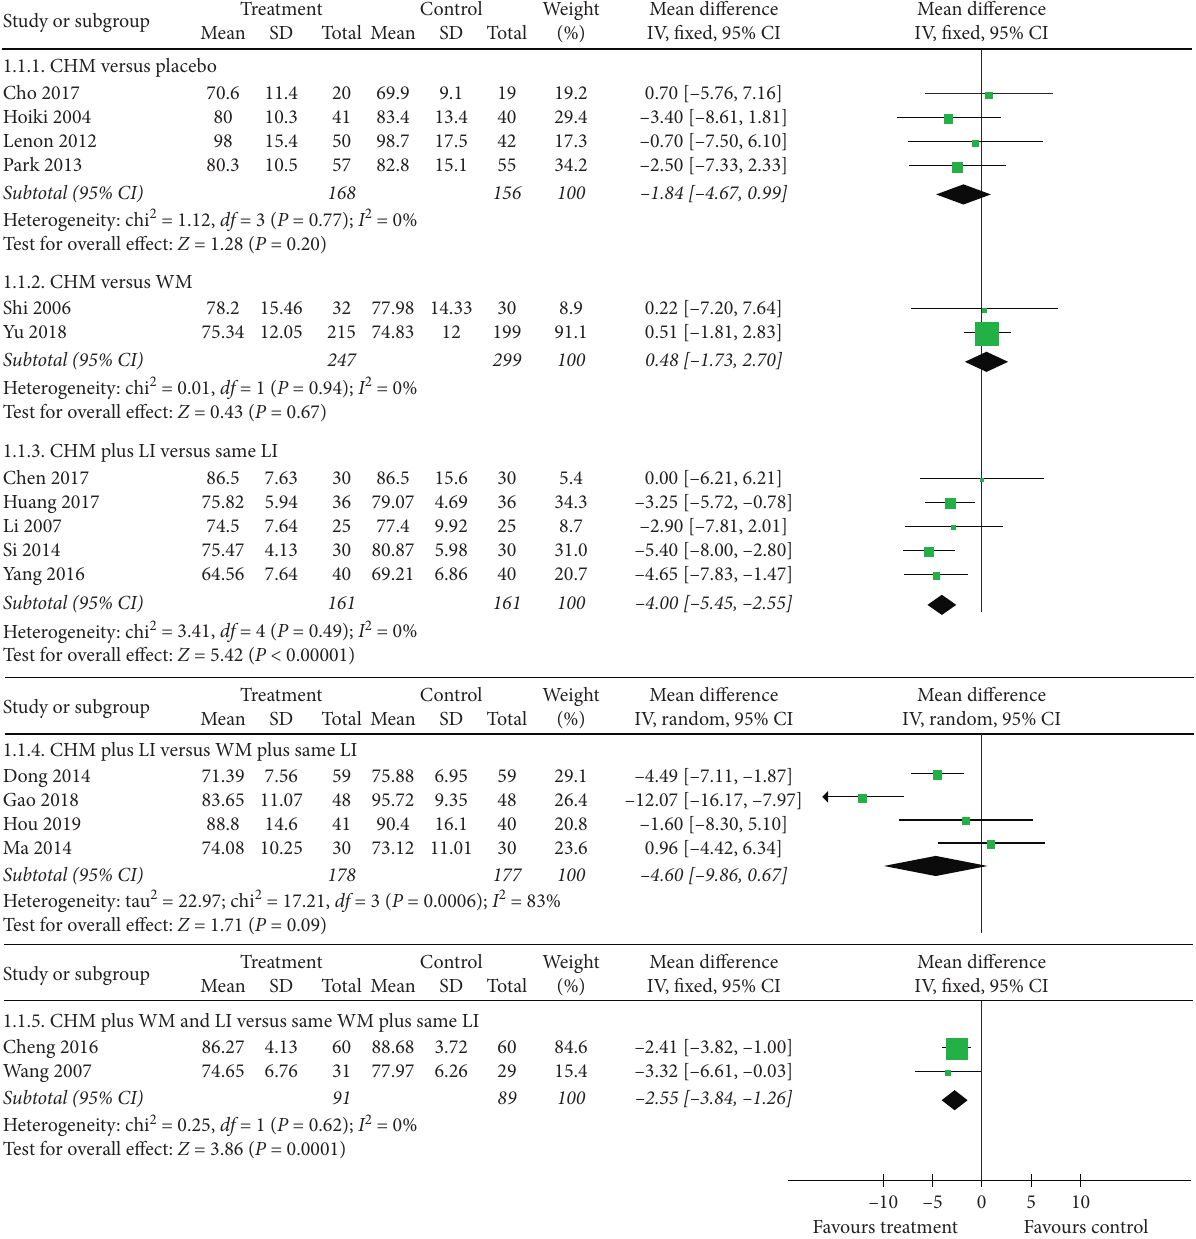
Figure 4: Comparison of body weight between Chinese herbal medicine treatment and control